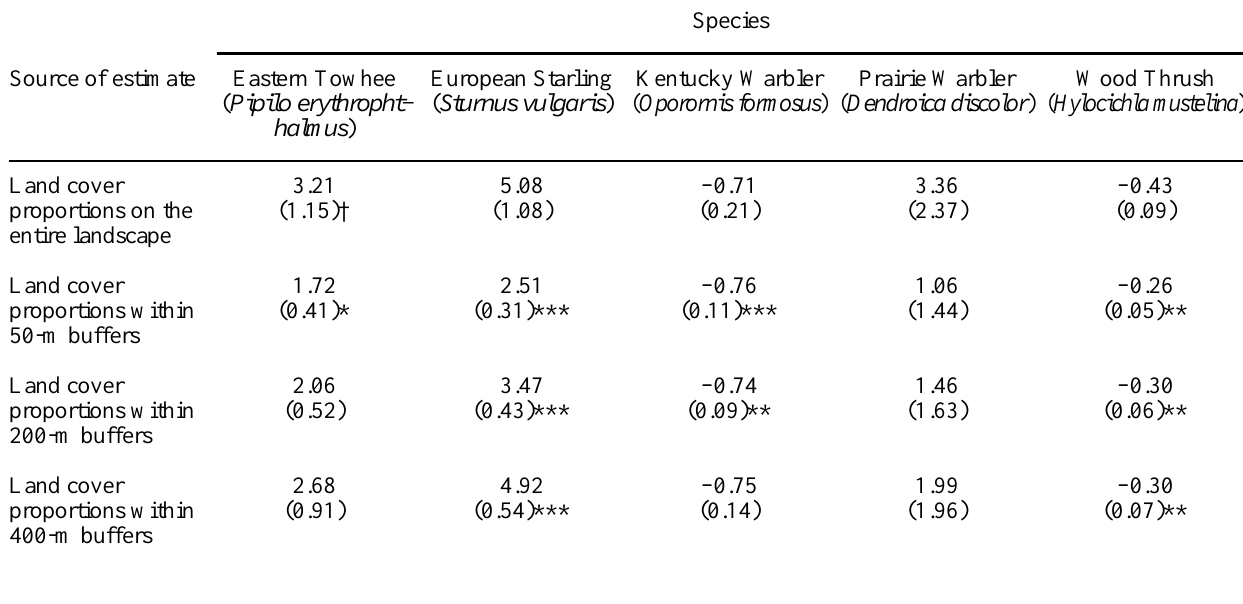
Table 7. Slope of the simulated population against time (% population change/yr) for five avian species of management interest based on roadside surveys and on the entire study region. Positive values indicate increasing populations; negative values indicate decreasing